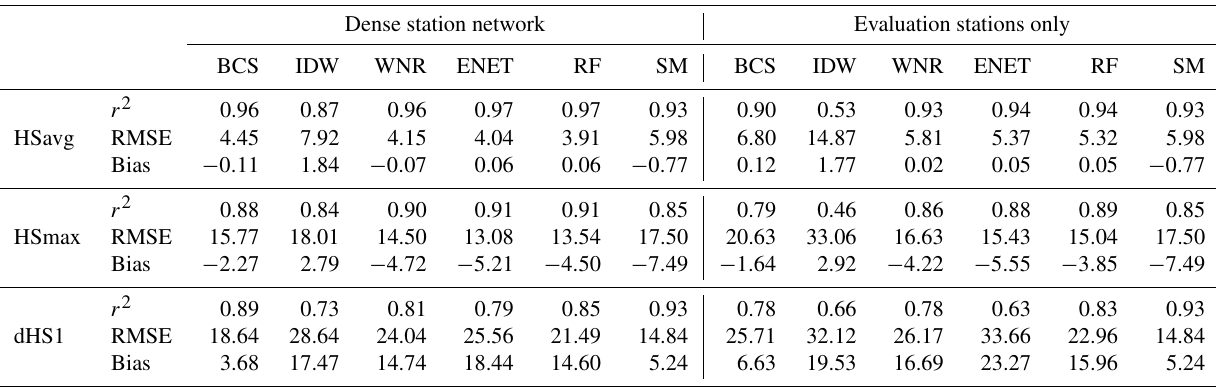
Table 2. Bias, RMSE and coefficient of determination ( r 2 ) for the three climate metrics HSavg, HSmax and dHS1 reconstructed with the different methods in the dense and sparse station networks as shown in Fig.